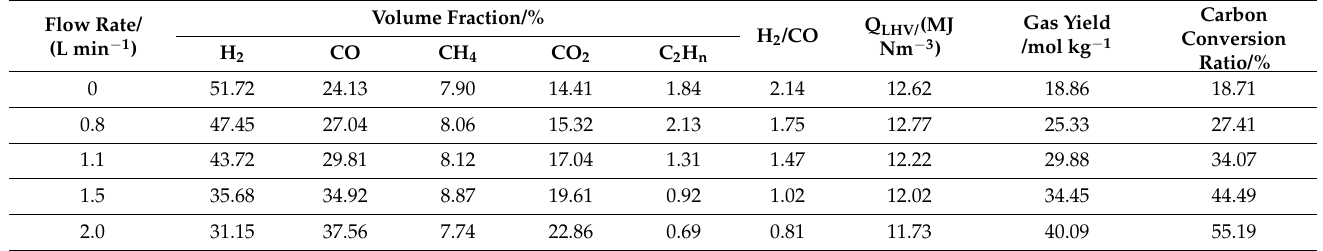
Table 4. The effect of the CO 2 flow rate on the gas characteristics of lignite gasification at 900 ◦ C. Flow Rate/ (L min − 1